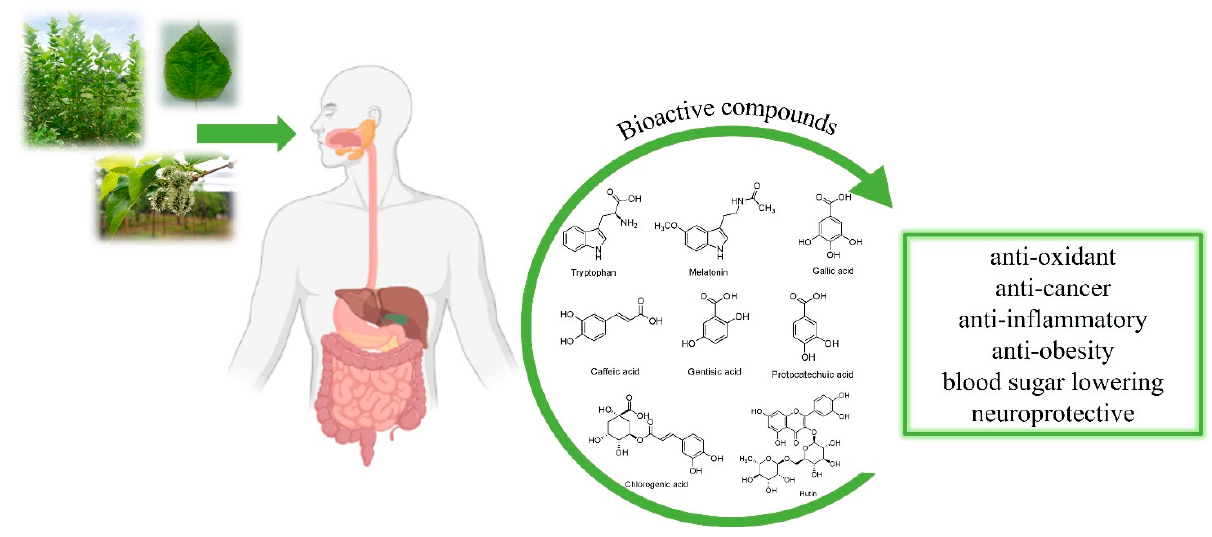
Figure 1. An overview of health benefits of mulberry consumption.